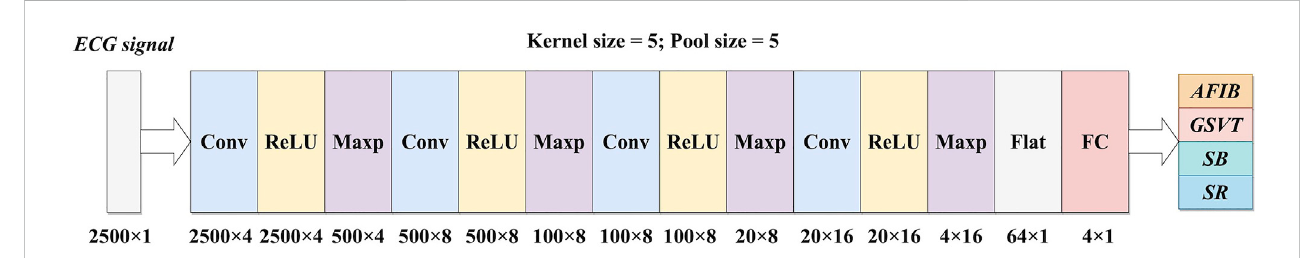
FIGURE 1 An overview of the proposed 1-D CNN. Conv : Convolutional layer; Maxp : Max-pooling layer; Flat : Flatten layer; FC : Fully-connected layer; AFIB : atrial fi brillation; GSVT : general supraventricular tachycardia; SB : sinus bradycardia; SR : sinus rhythm.